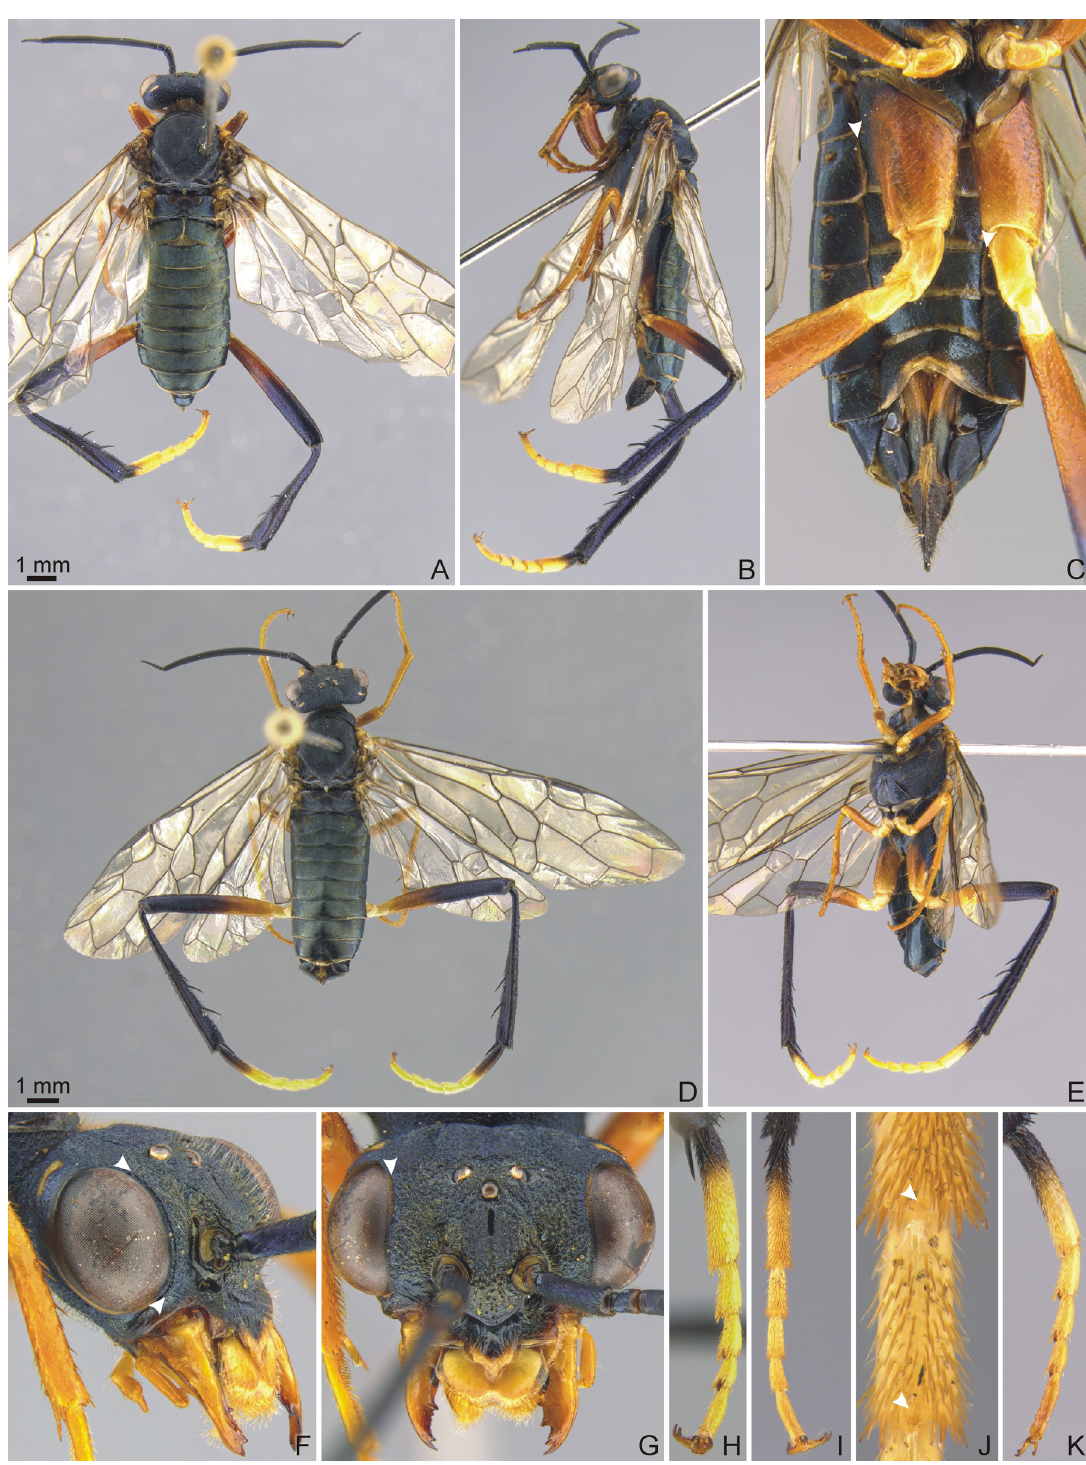
Fig. 3. Megaxyela euchroma Blank, Shinohara & Wei sp. nov. A–B . Habitus dorsal/lateral (♀, holotype, DEI-GISHym 22554, CSCS). C . Abdomen ventral, arrowheads indicating white stripe along ventral edge of terga (♀, 22511, NSMT). D–E . Habitus dorsal/lateroventral (♂, 22514, NSMT). F–G . Head, obliquely lateral/frontal, arrowheads indicating carina along inner orbit (♂, 22510, NSMT). H–K . Metatarsus, lateroventral (♀, holotype, 22554, CSCS), ventral (♀, 22510, NSMT), tarsomeres 1–2, ventral, arrowheads indicating small pulvilli (♀, 22509, NSMT), lateroventral (♂, 22513,